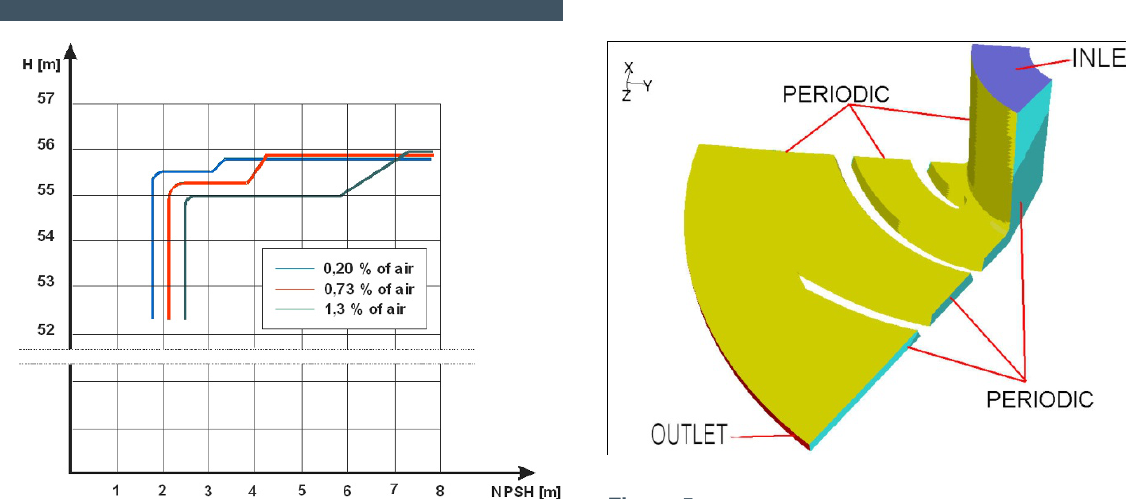
Figure 5. Geometrical model of the impeller E3 with marked bound- ary